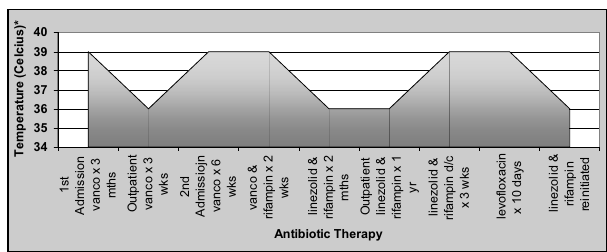
Figure 1) Febrile illness in relation to antibiotic therapy (*Temperature approximated to represent presence or absence of fever). Vanco